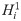
Figures show the construction of node potentials for the detection of the outer bowel wall.All figures are displayed in radial coordinates, with the distance from origin shown in the vertical axis, and the angle of rotation in the horizontal axis. The original image is shown top left. Top middle shows the gradient node potentials Hi1. Top right shows the cumulative node potentials Hi2. Bottom left shows the combined node potentials Vi. Bottom right shows the belief vectors bj. All measures are scale invariant.